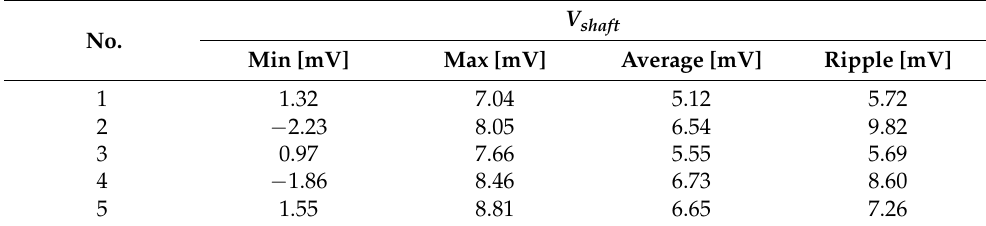
Table 1. First test result with a potential sensing voltage of 0.005 mV.